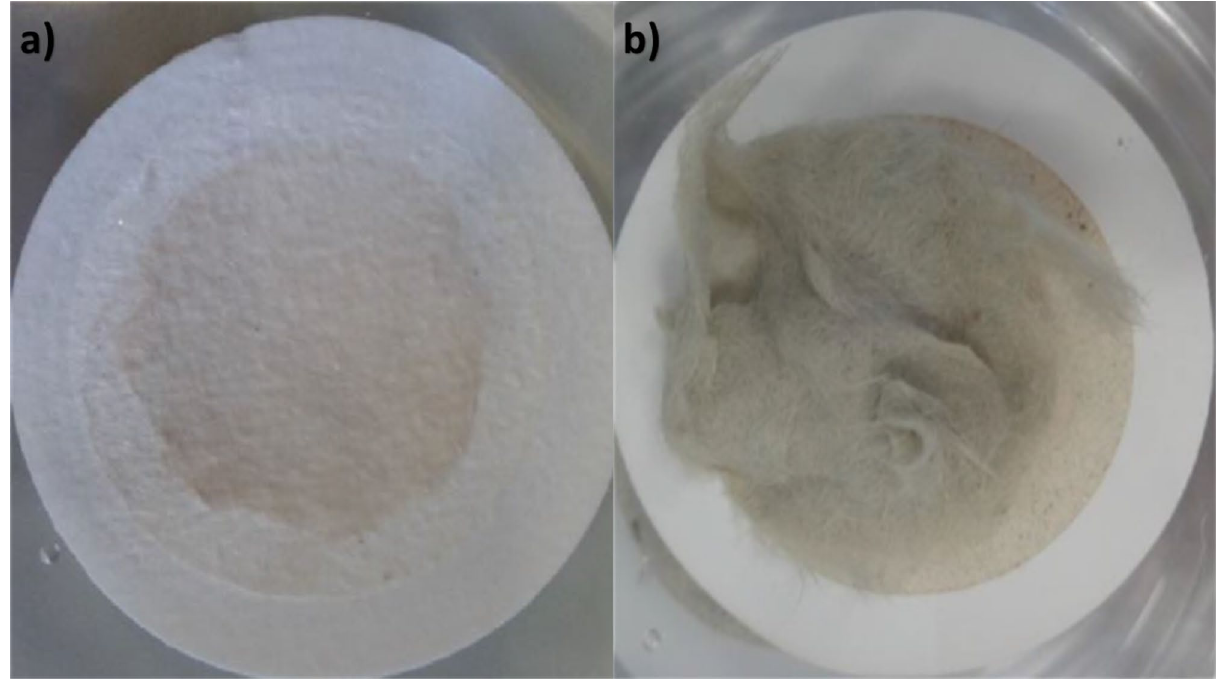
Figure 2. Filter before ( a ) and after ( b ) treatment with HNO 3 and H 2 O 2 mixture to dissolve the chaetes of Hermodice carunculata .